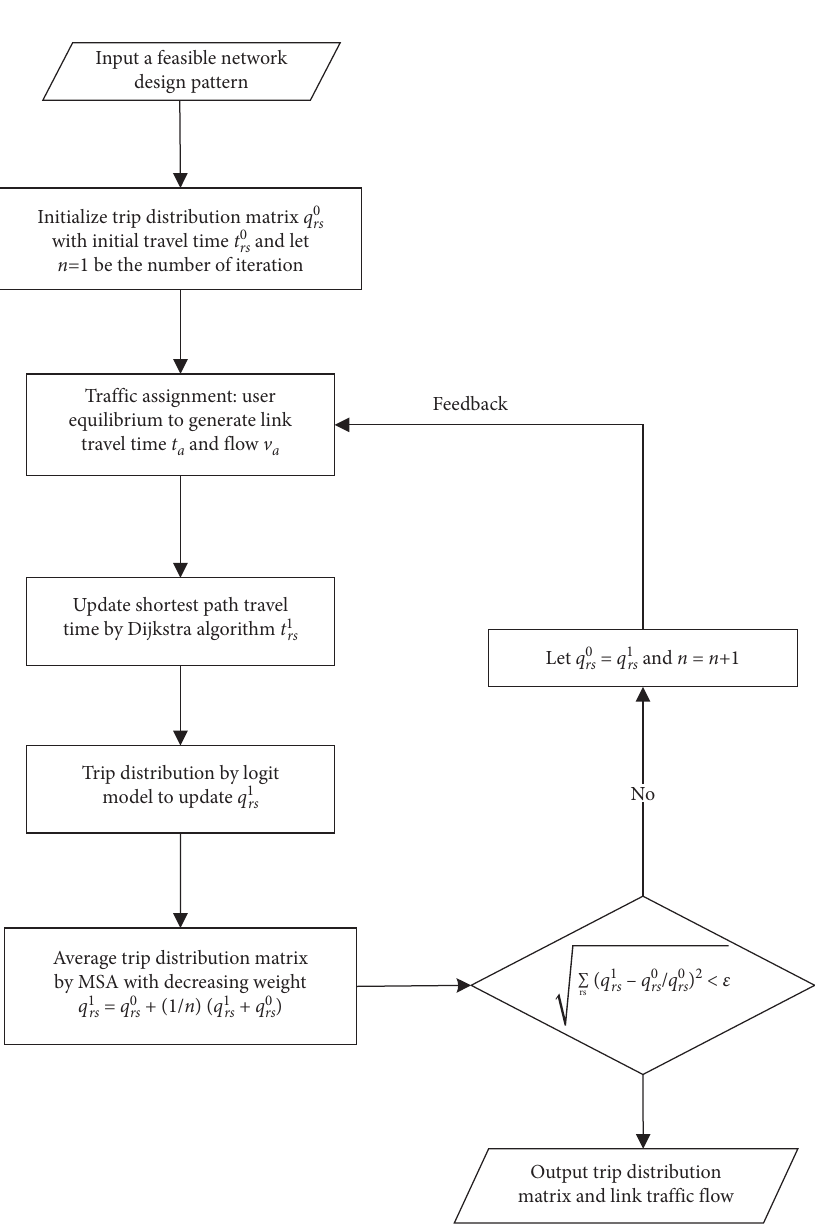
Figure 3: The flowchart of MSA